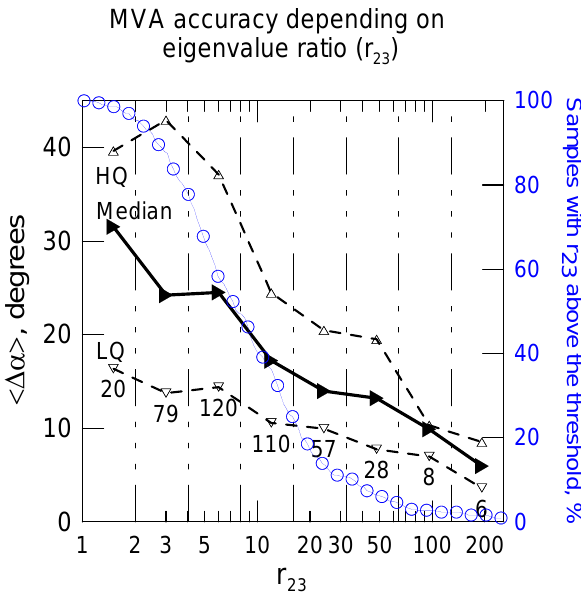
Fig. 2. Performance of MVA as a function of eigenvalue ratio r 23 . Angular differences from the TIM normal (characterized by median and high (HQ) and low (LQ) quartiles, where the number of events in every bin) is shown together with the number of events (circled curve) with r 23 exceeding the given